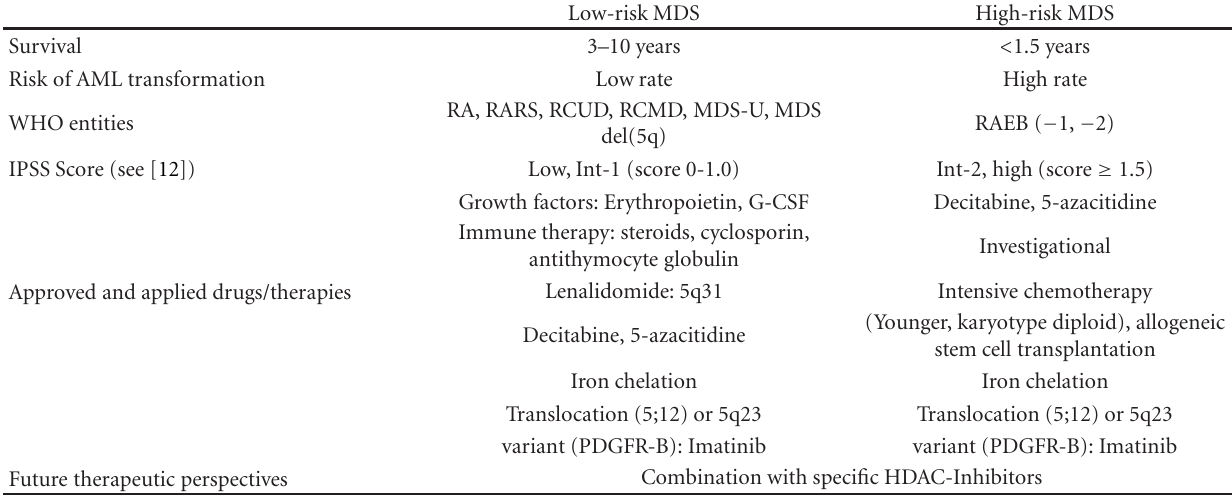
Table 1: Therapeutic strategies in MDS depending of risk stratifying (adapted from [59,